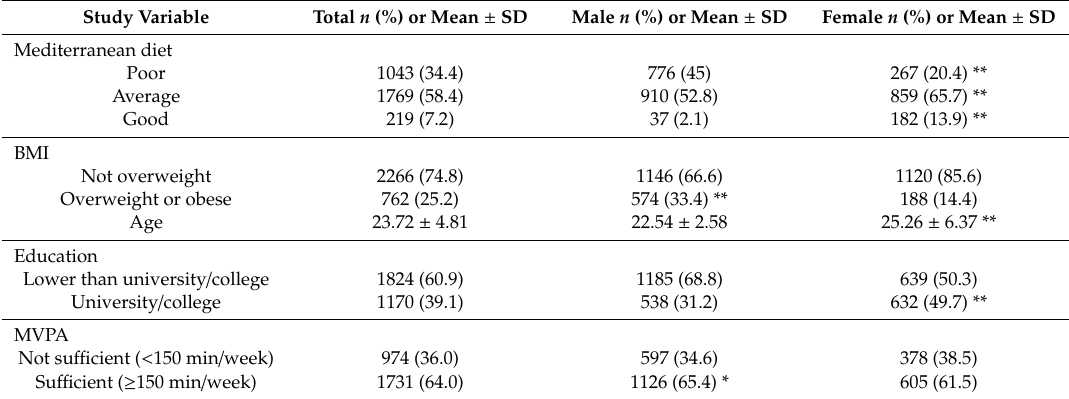
Table 1. Descriptive statistics and comparison of study variables between genders (total n = 3031).